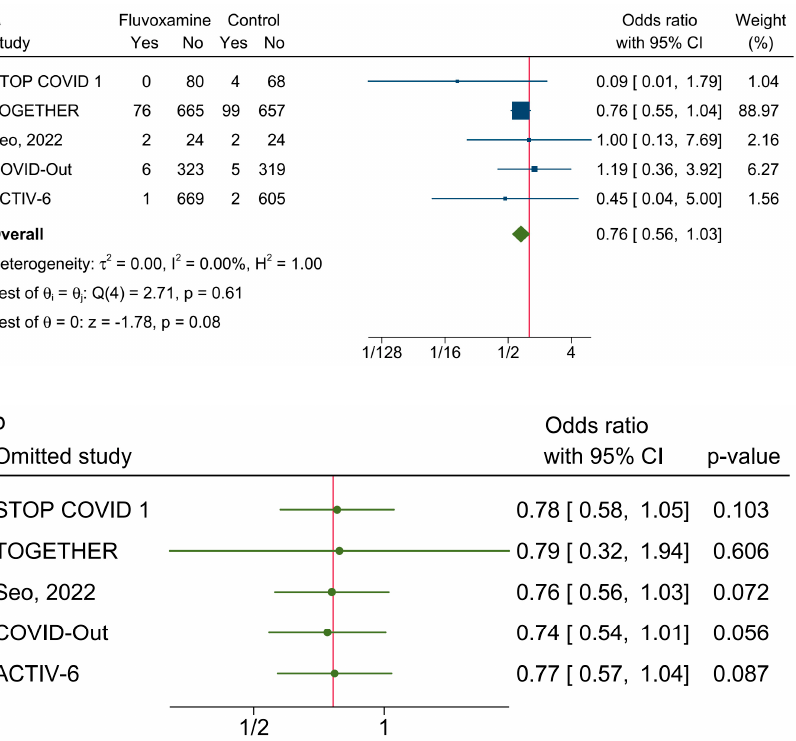
Figure 3. ( a ). Forest plot of random-effects meta-analysis of clinical deterioration. ([6–8,16–18]) ( b ). The leave-one-out test for the primary outcome. ([6–8,16–18]).